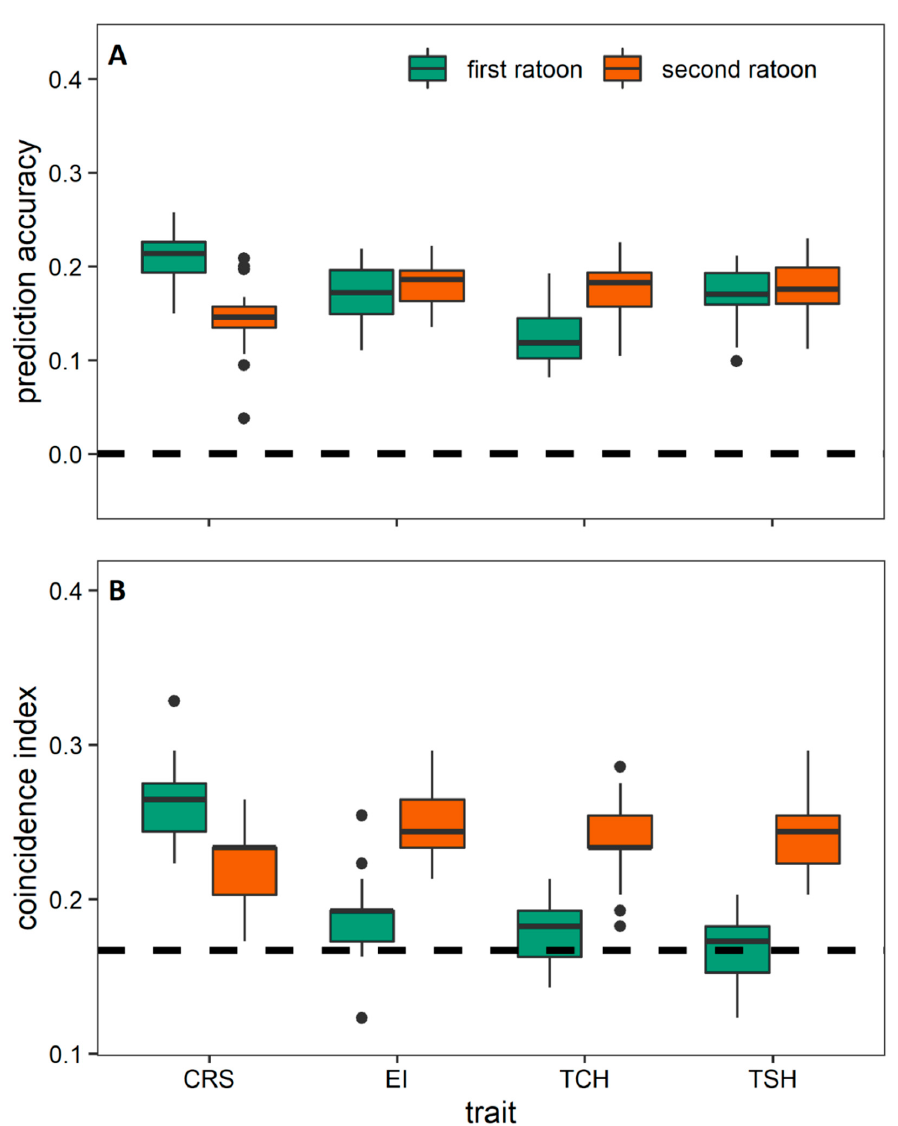
Figure 4. Prediction accuracy (A) and coincidence index (B) of the genomic estimated breeding es- timated value (GEBV) of four secondary traits for fivefold cross-validation (fivefold CV) of seven genomic selection (GS) methods. The fivefold CV was performed using plant cane data as the train- sugar (CRS), economic index (EI), ton cane per hectare (TCH), and ton sugar per hectare